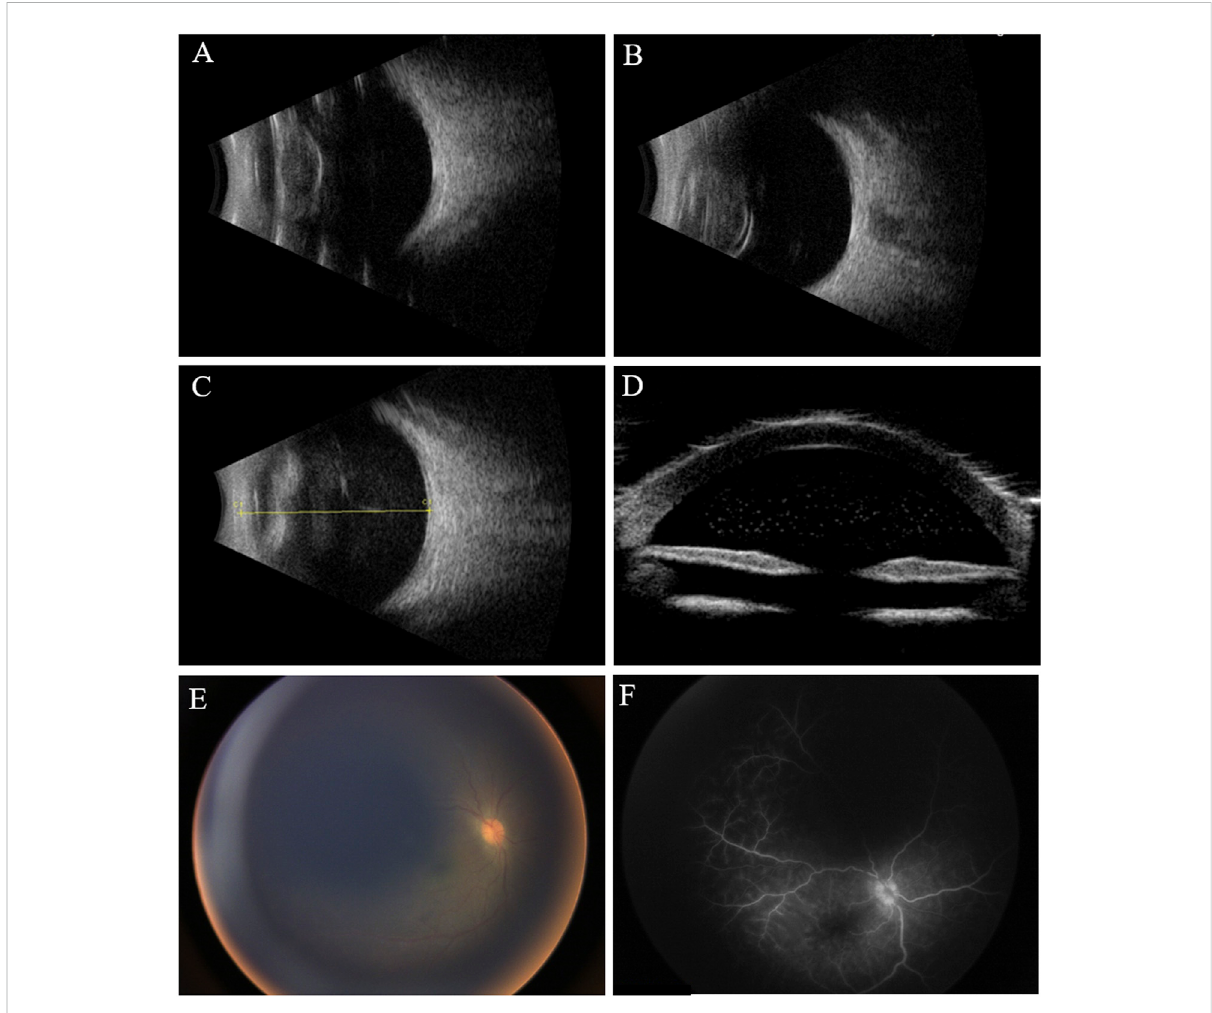
FIGURE 1 Clinical examination of the eyes at different times. (A,B) B-scan ultrasound shows opaci fi ed but otherwise normal-shaped lenses in both eyes before cataract surgeries. (C) B-scan ultrasound shows opaci fi ed vitreous 1 year after the cataract surgery; (D) ultrasound biomicroscopy (UBM) shows hyperechogenic dots in the anterior chamber; (E) fundus photography reveals hazy vitreous and congested optic nerve head; (F) venous phase of fl uorescein angiography shows leakage of retinal capillaries and a hyper fl uorescent optic nerve